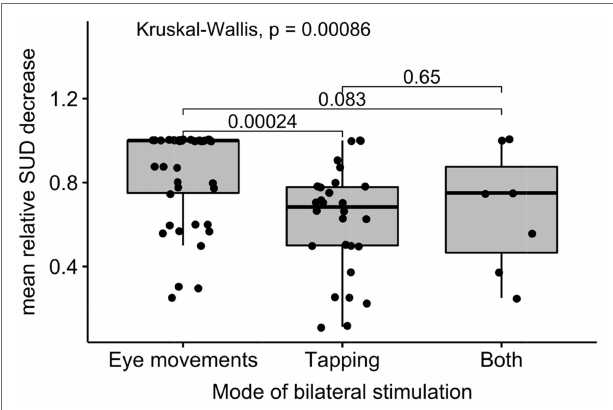
FIGURE 5 | Boxplots for group differences between different modes of stimulation.